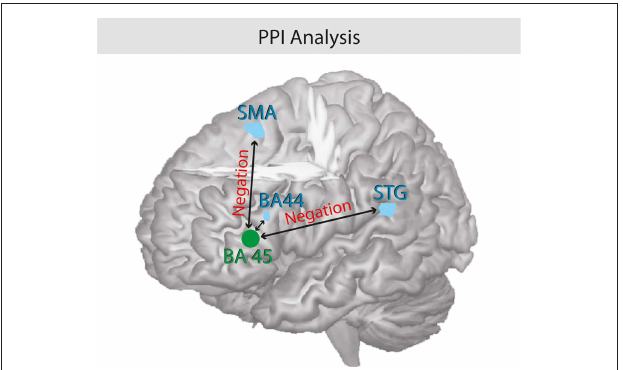
FIguRE 5 | Psychophysiological interaction analysis of negation. Illustration of the functional coupling between the seed region pars triangularis (BA 45) and the pars opercularis (BA 44), the left STG, and the SMA. The processing of negations triggers the coupling of the hemodynamic response between the